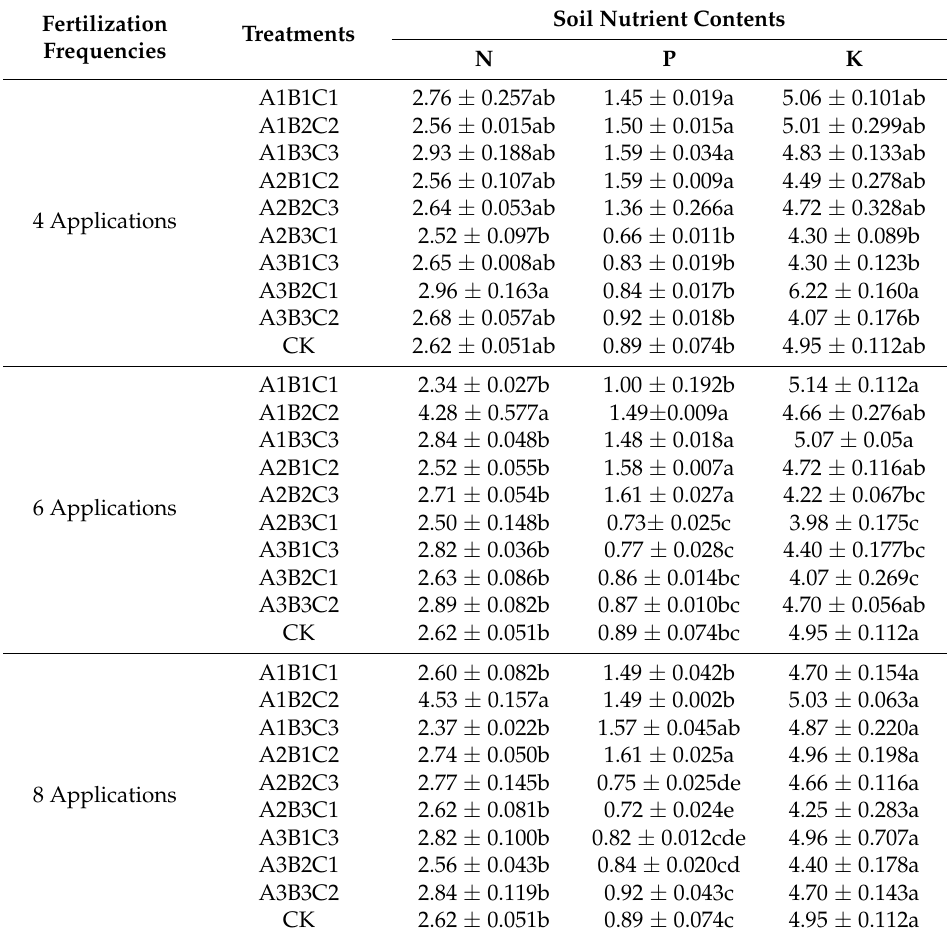
Table 13. Effects of different fertilization ratios and frequencies on soil nutrient contents. Fertilization